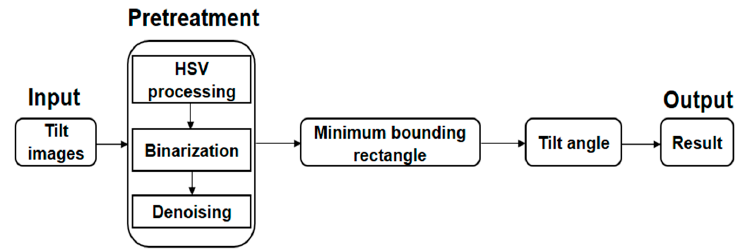
Figure 4. Algorithm flowchart.